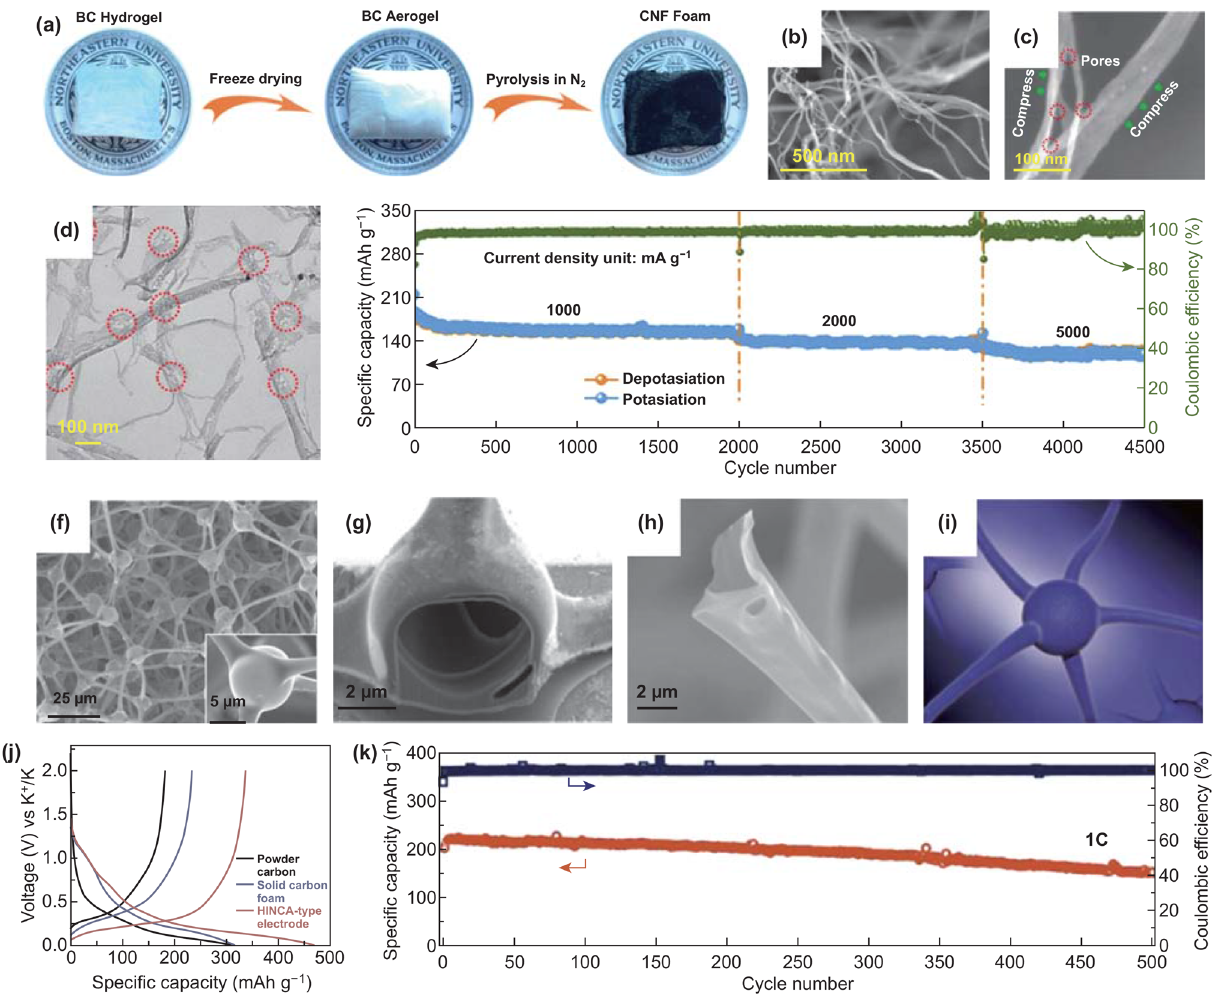
Fig. 12 a Schematic diagram of preparation of CNFF. SEM images of b CNFF and c CNFs. d TEM image of CNFF. e Long-term cycling per- formance of CNFF electrode at three current densities. The battery rested for 10 days before using different current density. Reproduced with permission from Ref. [225]. Copyright 2018, American Chemical Society. f SEM image of HINCA and its tetrapod center (inset). SEM images of g the tetrapod-joint cross section and h a tetrapod-unit broken arm. i Neuron structural Cartoon. j Charge/discharge curves of the 1 st cycle at 0.1 C (28 mA g −1 ). k). Long cycle performance of the HINCA-type product at 1 C. Reproduced with permission from Ref. [226].